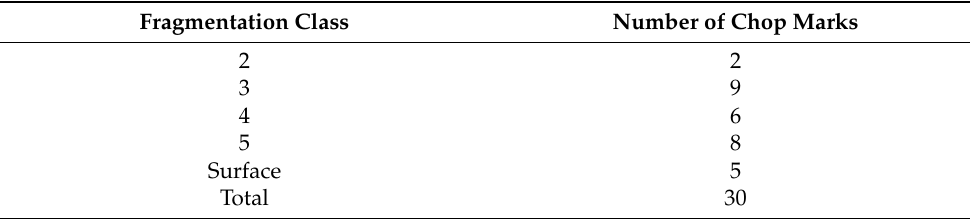
Table 7. The frequency distribution of experimental bronze chop marks by Fragmentation